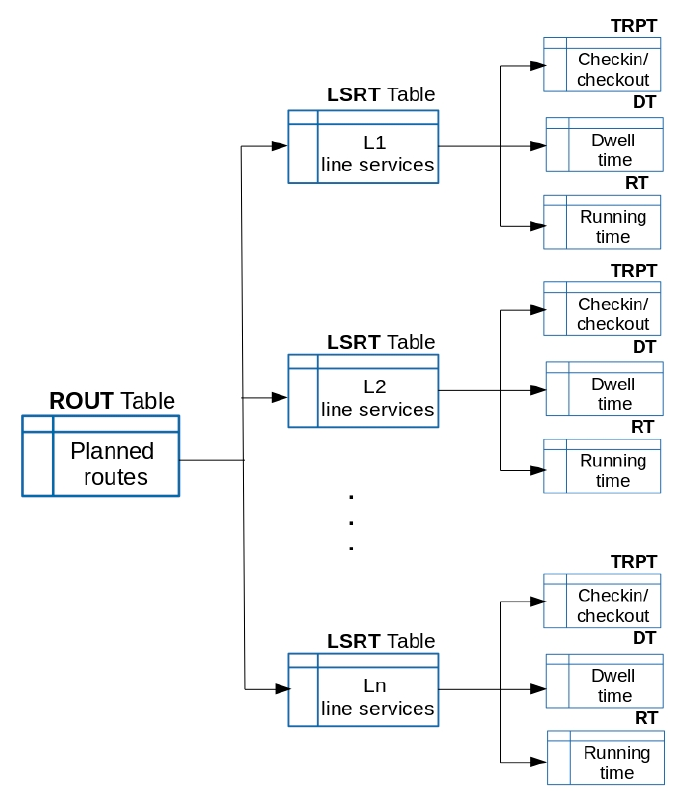
Figure 4. Framework dynamic